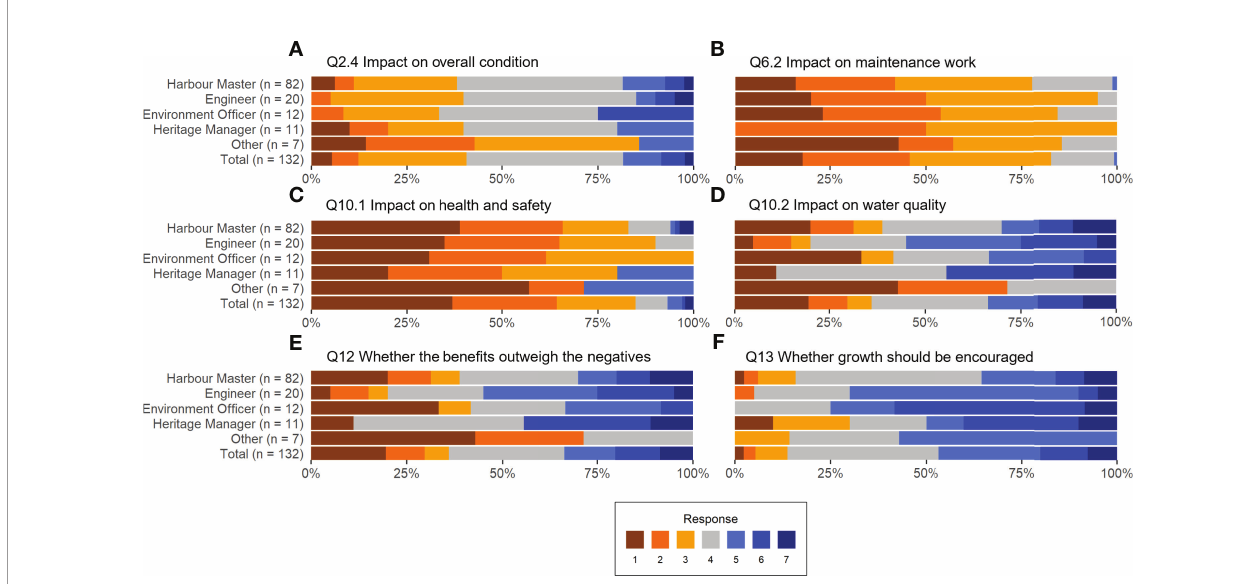
FIGURE 2 | Responses to a selection of scalar questions in the questionnaire differentiated by occupational group. The questions relate to the impact of marine growth on (A) the overall condition of a structure, (B) maintenance work, (C) health and safety, (D) water quality, and whether (E) the bene fi ts of marine growth outweigh the negatives and (F) whether marine growth should be encouraged or